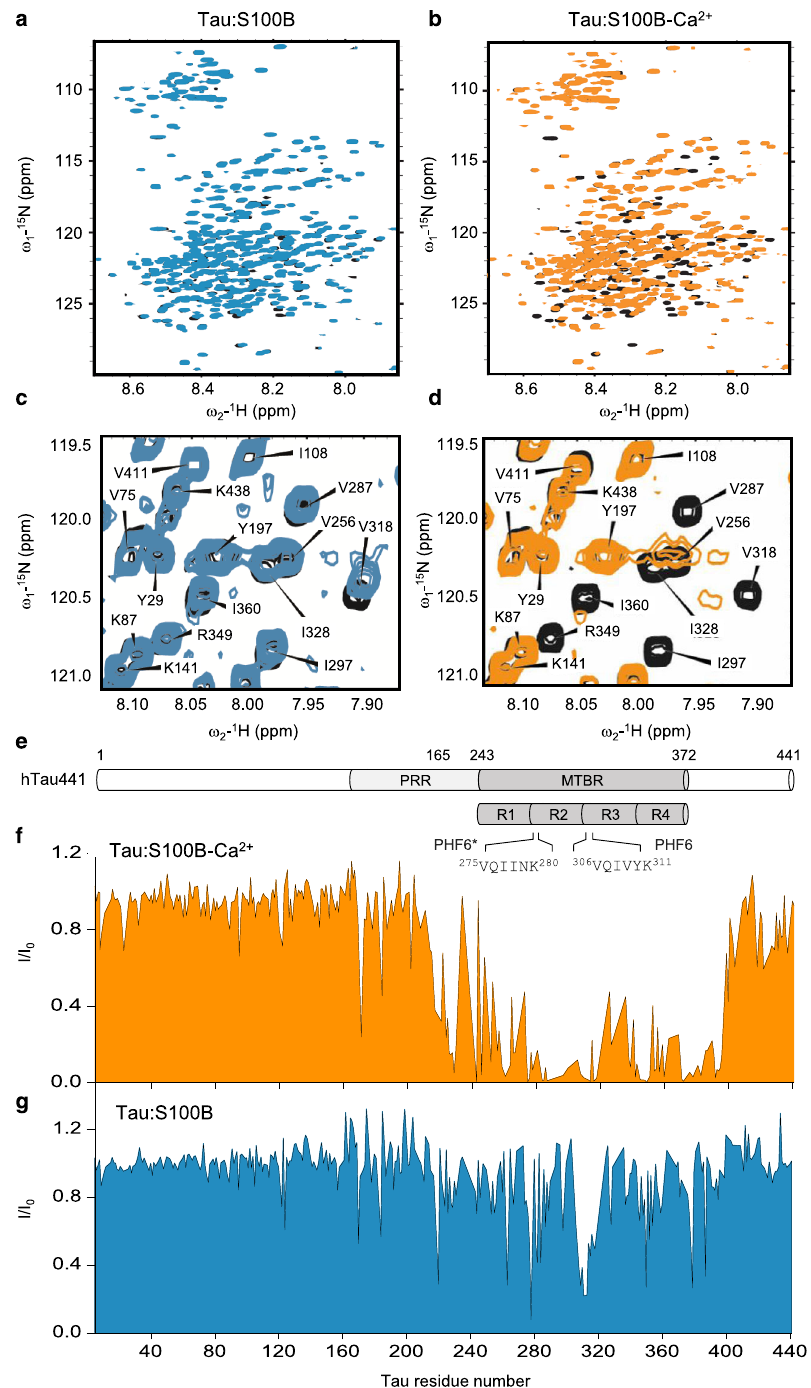
Fig. 2 Mapping S100B interactions to tau. a , b 2D 1 H, 15 N HSQC spectra of 100 µ M 15 N-tau alone (black), in the presence of 120 µ M S100B and 1.25 mM EDTA ( a , blue), or in the presence of 120 µ M S100B and 250 µ M CaCl 2 ( b , orange). c , d Detail of HSQC-NMR spectra evidencing tau-resonance perturbations corresponding to residues affected by S100B binding. Parts per million (ppm). e Schematic representation of full-length tau highlighting the PRR and MTBR as well as the repeat regions R1 – R4 and the aggregation-prone segments PHF6* and PHF6, aligned with the x axis of plots f and g . f , g Intensity variation of each tau resonance in the presence of S100B and in the presence ( f , orange) or the absence ( g , blue) of calcium. Ratio of peak intensity over initial peak intensity (I/I 0 A control experiment showed that Ca 2 + had no effect on tau residues in the tau sequence (Fig. 2e). Indeed, comparison of the resonances (Supplementary Fig. 4), indicating that the observed intensity ratio of the corresponding resonances (I/I 0 ) in the spectrum of 15 N-tau in the presence of S100B-Ca 2 + (I) relative to changes result from binding of 15 N-tau to S100B-Ca 2 + . As the assignment of most tau resonances is available, we can link these the intensity in the spectrum of tau alone in solution (I 0 ) allowed mapping the interaction region (Fig. 2f, g). Perturbations intensity perturbations of resonances to speci fi c amino acid